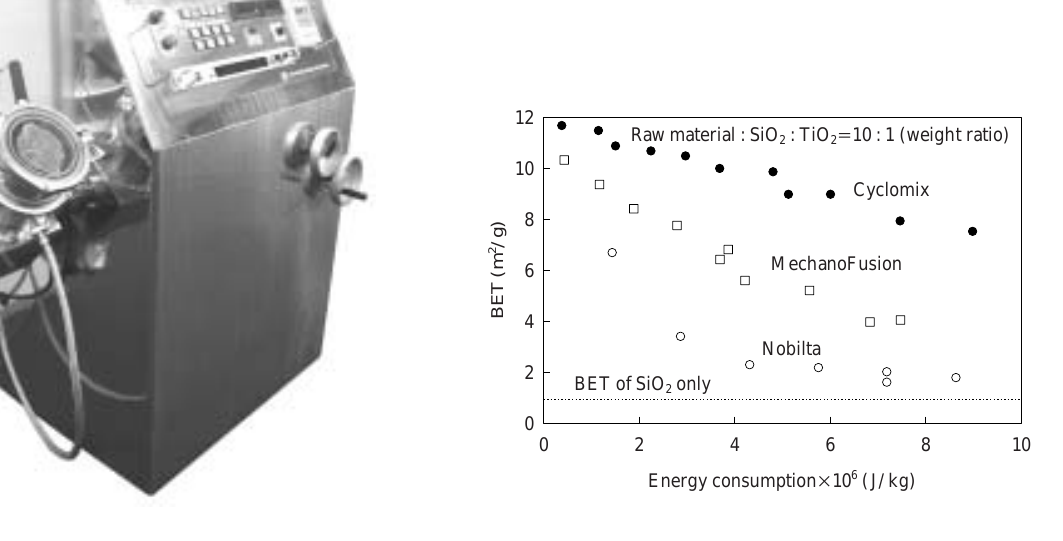
Fig. 9 Effect of particle bonding on the BET specific surface areas of powder